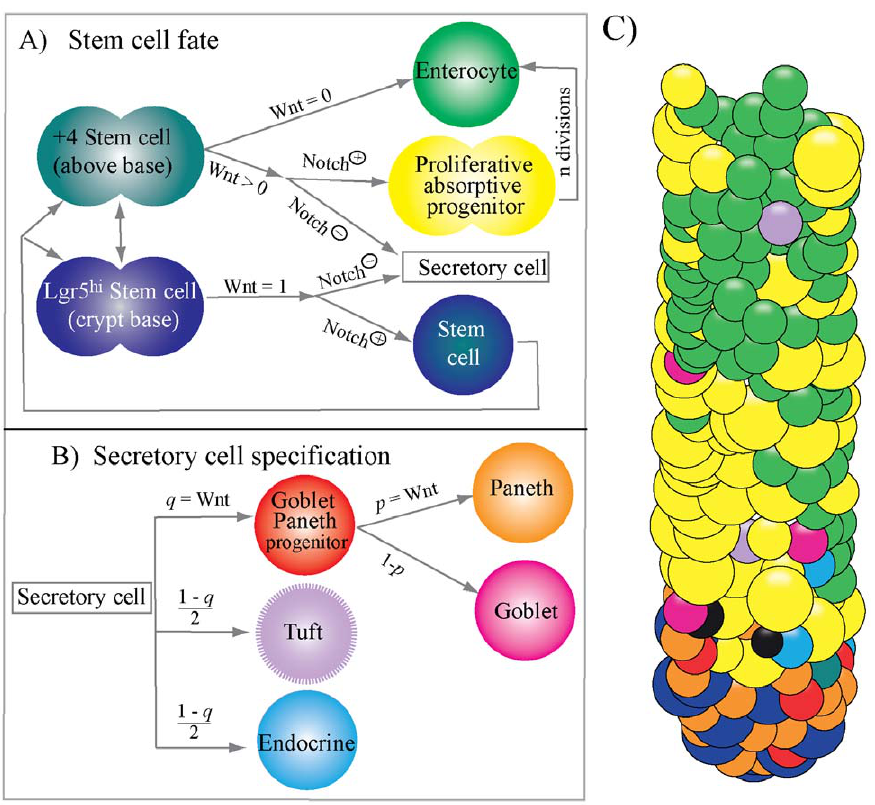
Figure 1. Model for cellular differentiation and proliferation in the crypt of mouse small intestine. A) Fate of stem cells progeny. Stem cells at the crypt bottom and at position + 4 replenish each other and give rise to different progeny according to the strength of Wnt signalling. Wnt signalling is quantified according to the local cell composition as described in Equation 1 with a maximum value of 1 in the crypt base. Under the highest levels of Wnt signalling at the crypt bottom (Wnt =1), stem cells progeny consists of secretory cells and stem cells. At lower levels of Wnt signalling (Wnt , 0) stem cells give rise to secretory cells and proliferative absorptive progenitors. In both cases the decision between these two fates, secretory and stem/absorptive, depends on Notch signalling. Differentiation into the secretory cellular lineage is inhibited if Notch is activated (Notch › ) as a result of 50% or more of adjacent cells belonging to the secretory lineage. B) Secretory cell specification. Secretory cells differentiate into goblet Paneth cell common progenitors with a probability estimated as q = Wnt signalling (quantified from Equation 1), otherwise secretory cells become either Tuft or enteroendocrine cells with equal probability. Goblet-Paneth cell common progenitors differentiate into Paneth cells with probability p = Wnt signalling (Equation 1), otherwise they differentiate into goblet cells. C) A snapshot of the simulated crypt in steady state shows how all cell types locate on the three dimensional spiral.